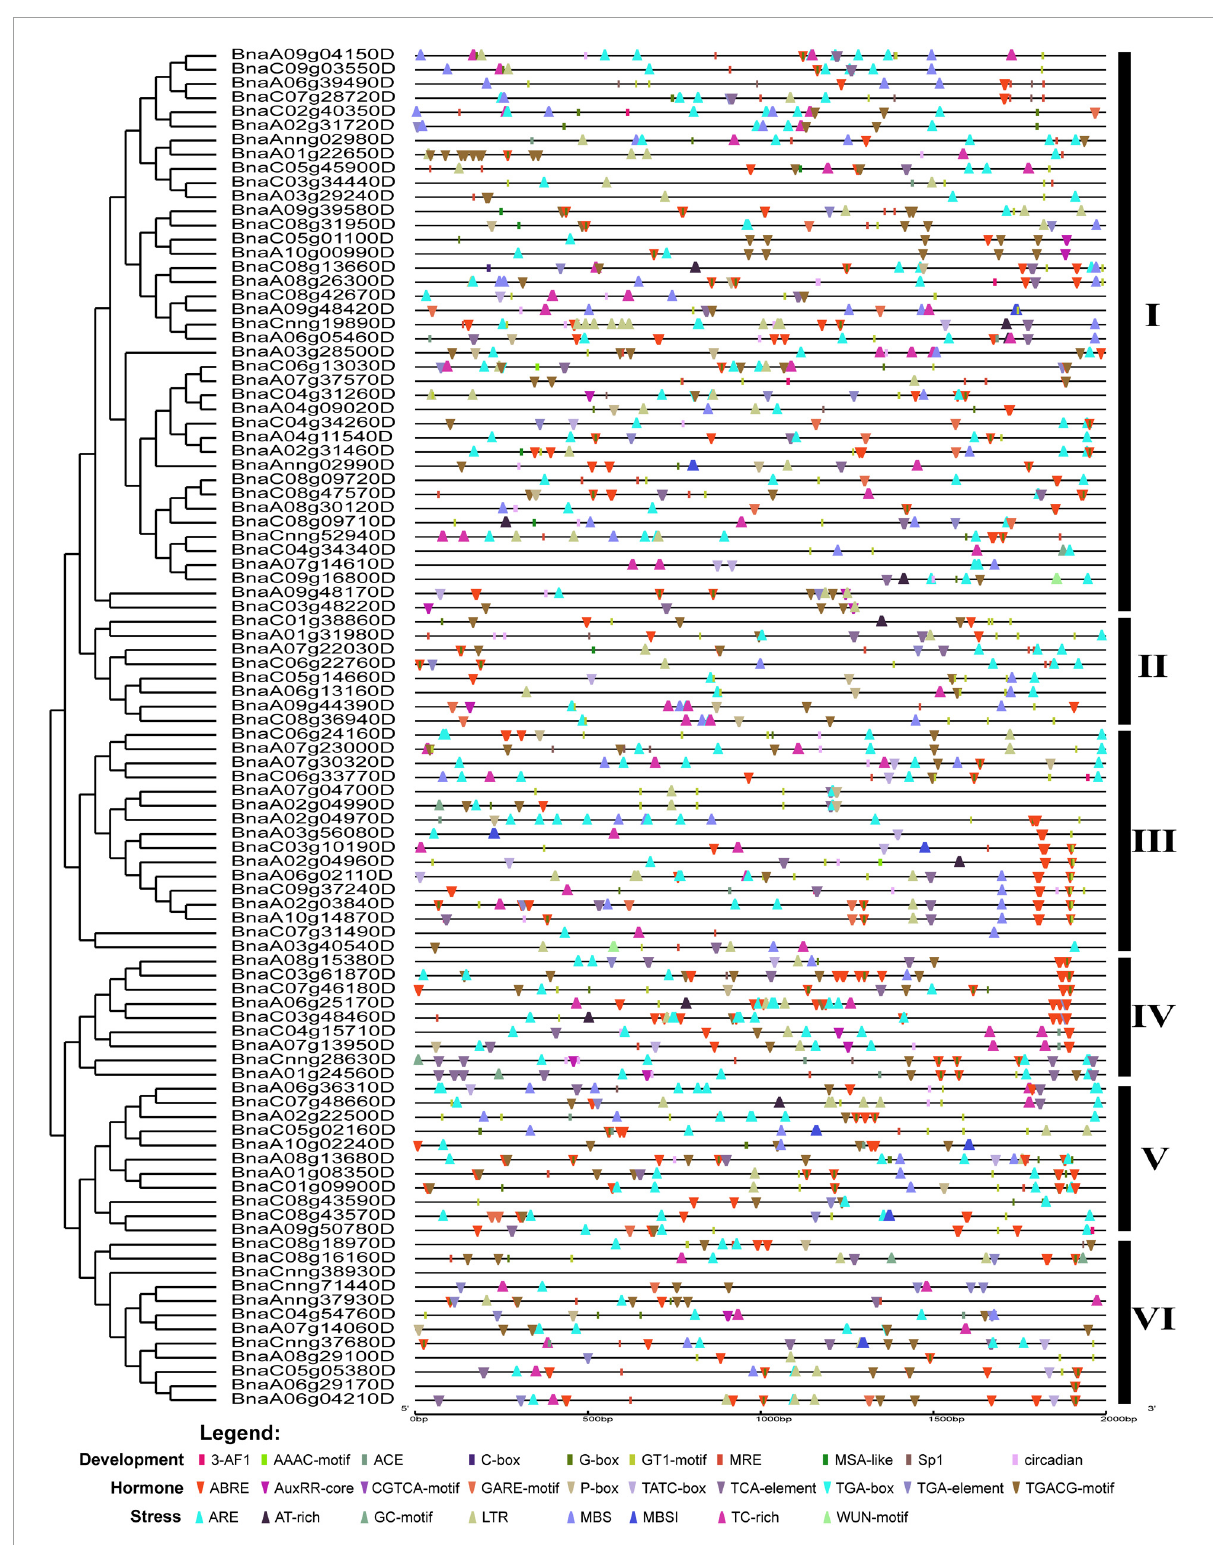
FIGURE4 Cis -acting regulatory elements identified in promoters of BnCDP genes in Brassica napus . Boxes indicate development-related elements, down-wedges indicate hormone-related elements, and up-wedges indicate stress-related elements. Different colors indicate different